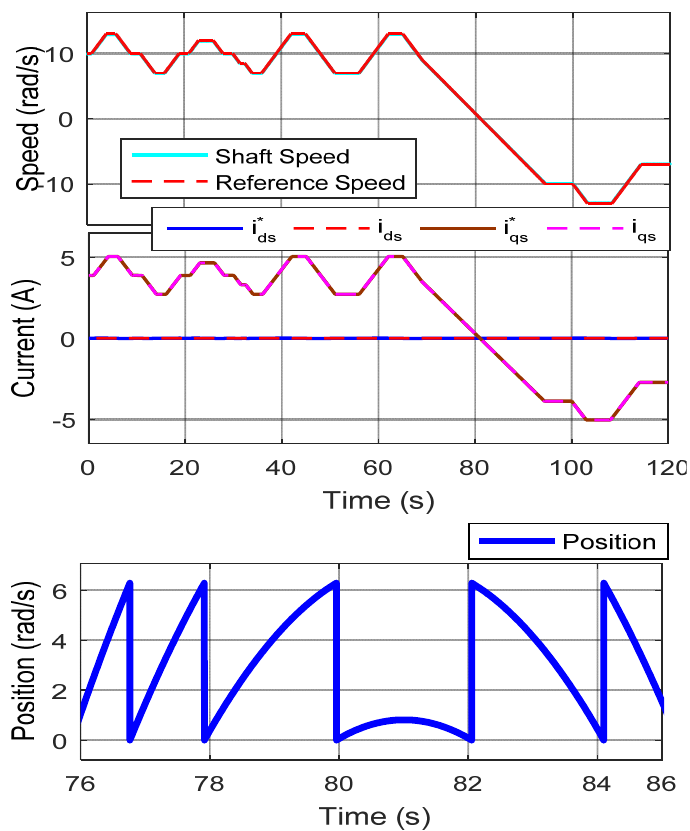
Figure 4. The drive was tested for the forward motoring and reverse motoring operations for various speed commands.